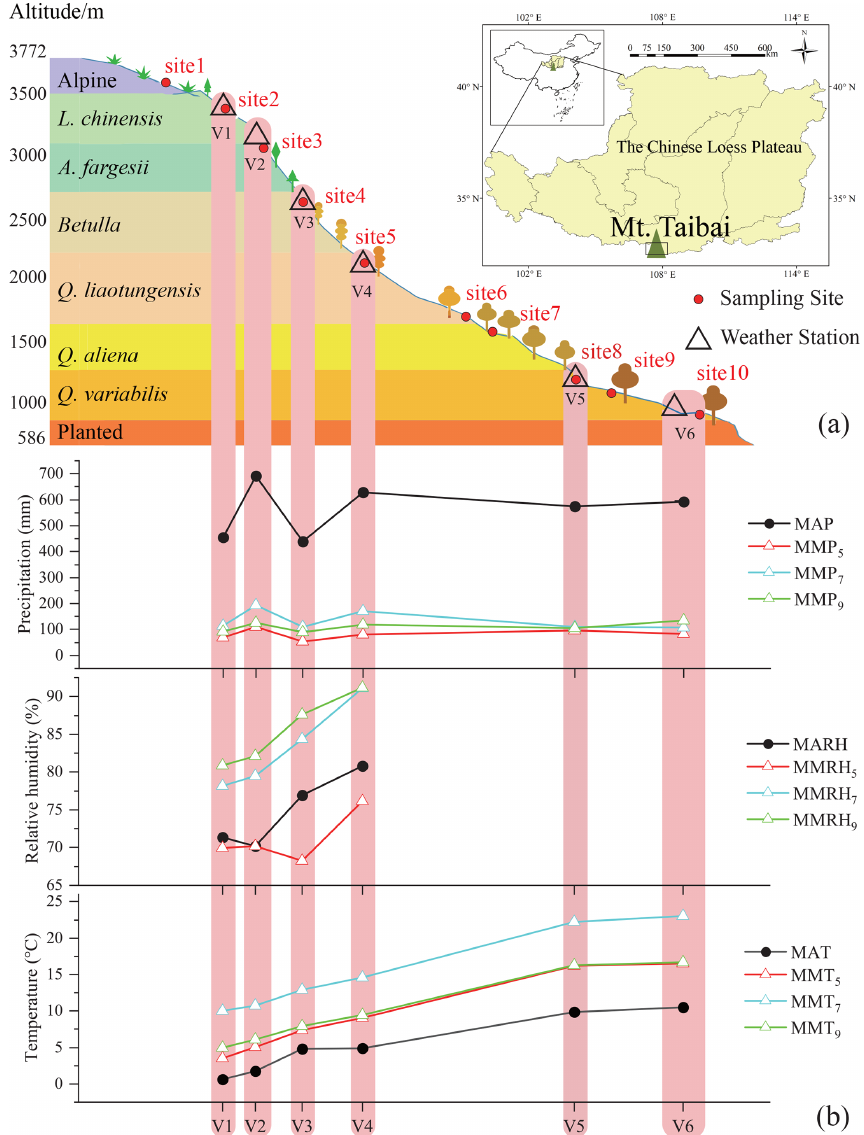
Figure 1. Sample sites (red dots) and weather stations (open triangles) that are distributed along vertical vegetation zones across the Mt. Taibai transect on the Chinese Loess Plateau (a) . The meteorological parameters (precipitation, temperature, and relative humidity) vary with stations along the elevation transect (b) . Mean annual (MAP, MAT, MARH) and monthly (MMP, MMT, MMRH) precipitation, temperature, and relative humidity. The subscripts refer to the month. The vertical vegetation distribution was adopted from Liu